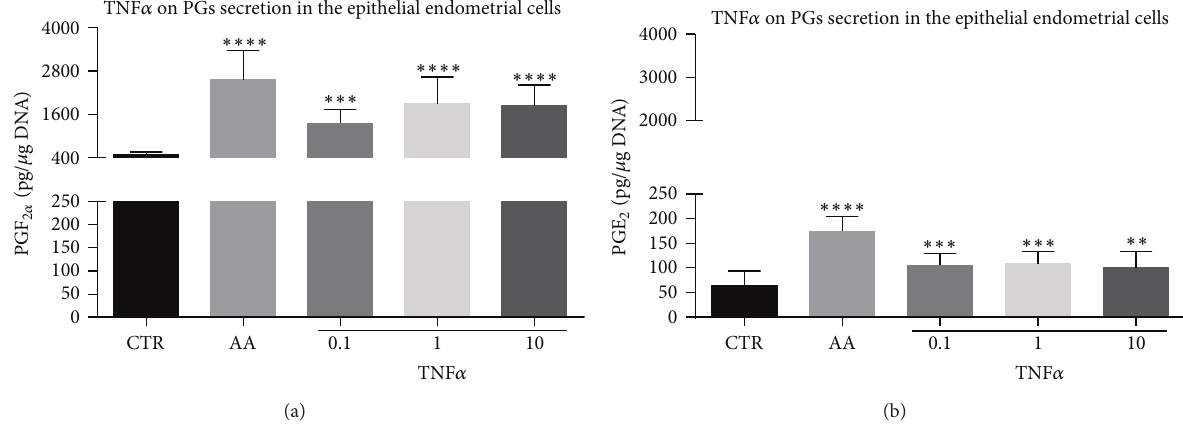
and 1ngmL −1 , resp.). Asterisks indicate statistical differences between numbers of spots depending on the treatment ( ∗∗∗ 𝑃 < 0.001 ).